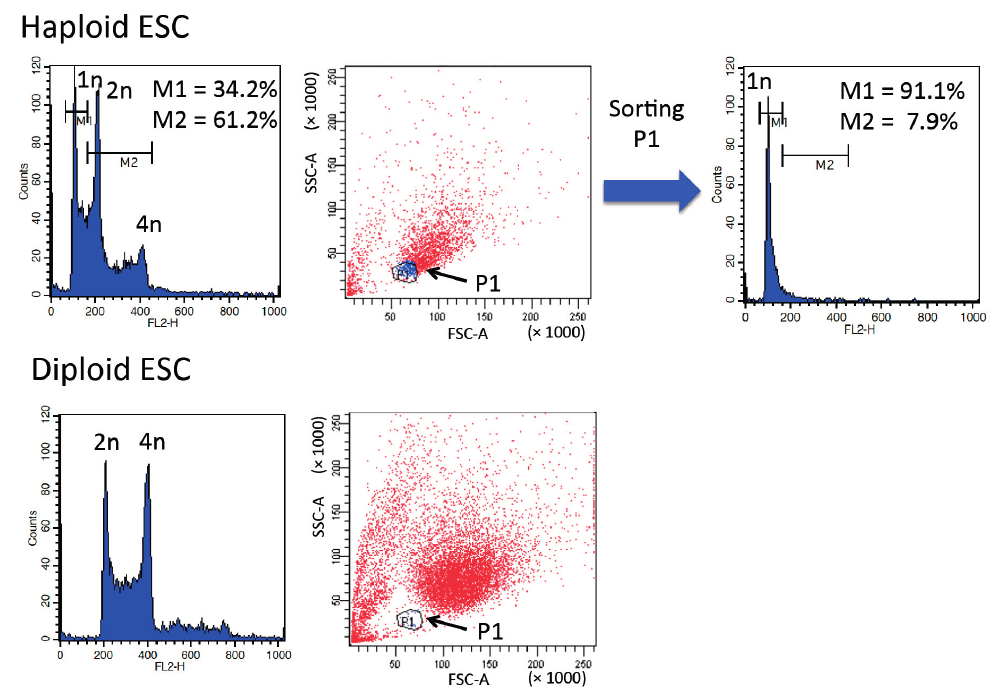
Figure 3. Identification of haploid ESCs by Hoechst 33342 staining. Cells with haploid G1 content (1 n peak) are purified by fluorescence-activated cell sorting (FACS) using a near-UV laser (375 nm).